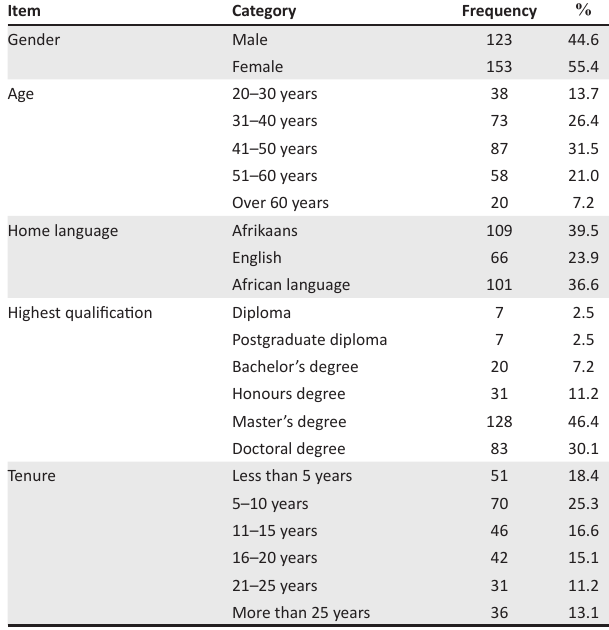
TABLE 1: Characteristics of the participants ( n =